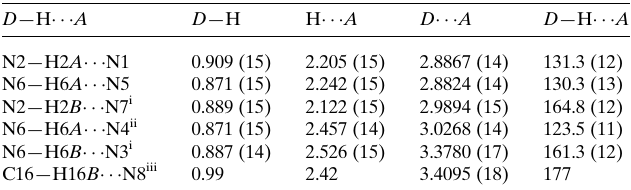
Table 2 Experimental